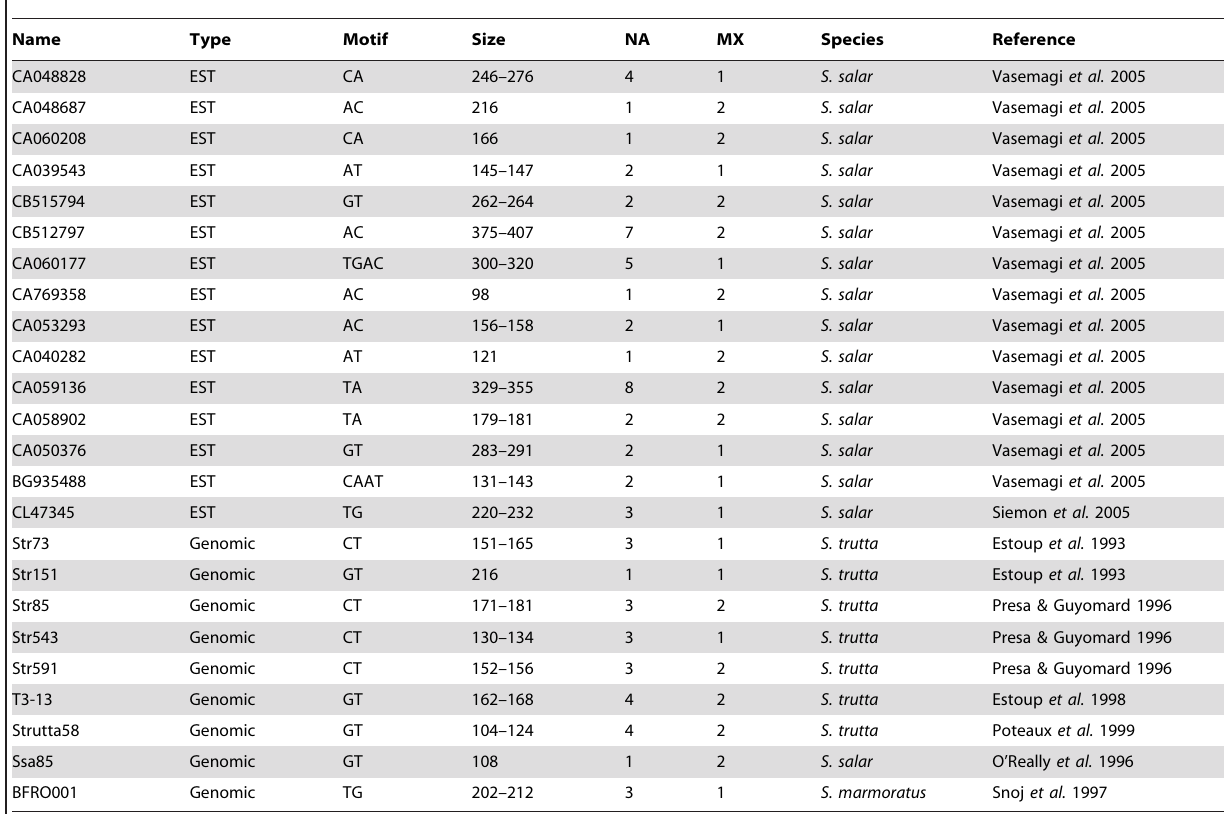
Table 2. Microsatellite loci analyzed in marble trout including microsatellite type, repeat motif, size range (in bp), maximum number of alleles per locus (NA), and species in which the microsatellites were originally developed ( Salmo salar , S. trutta , S. marmoratus